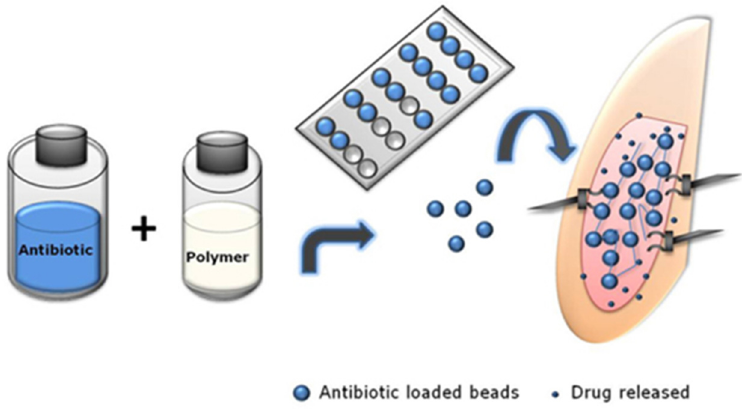
Figure 3. The in situ implantation of antibiotic-impregnated beads, as a local antibiotic delivery system, works to obliterate bacteria in the area as well as to reduce the dead space in the bone [19]. Adapted with permission from ref. [19]. A 2013 Creative Commons Attribution (CC BY) license.